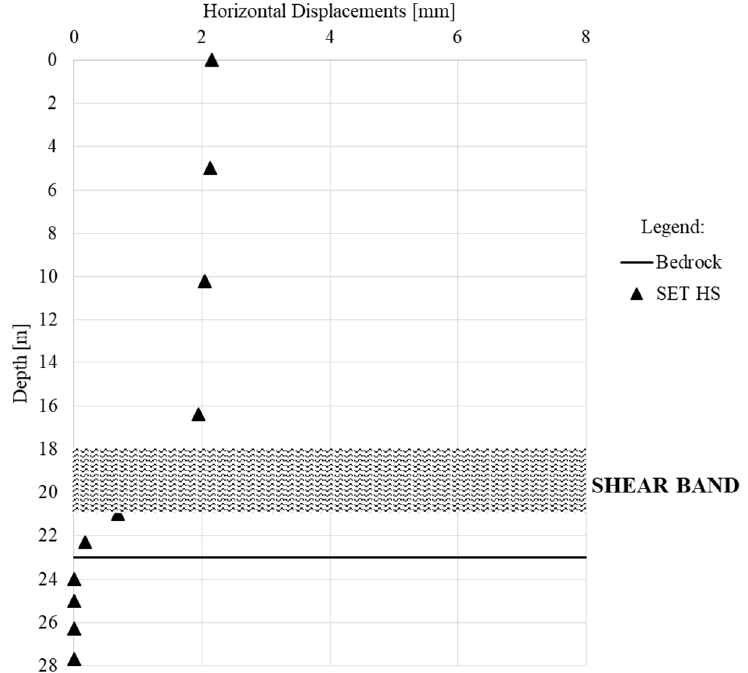
Figure 17. Safety analysis results after the groundwater level fall (SF = 1.357).